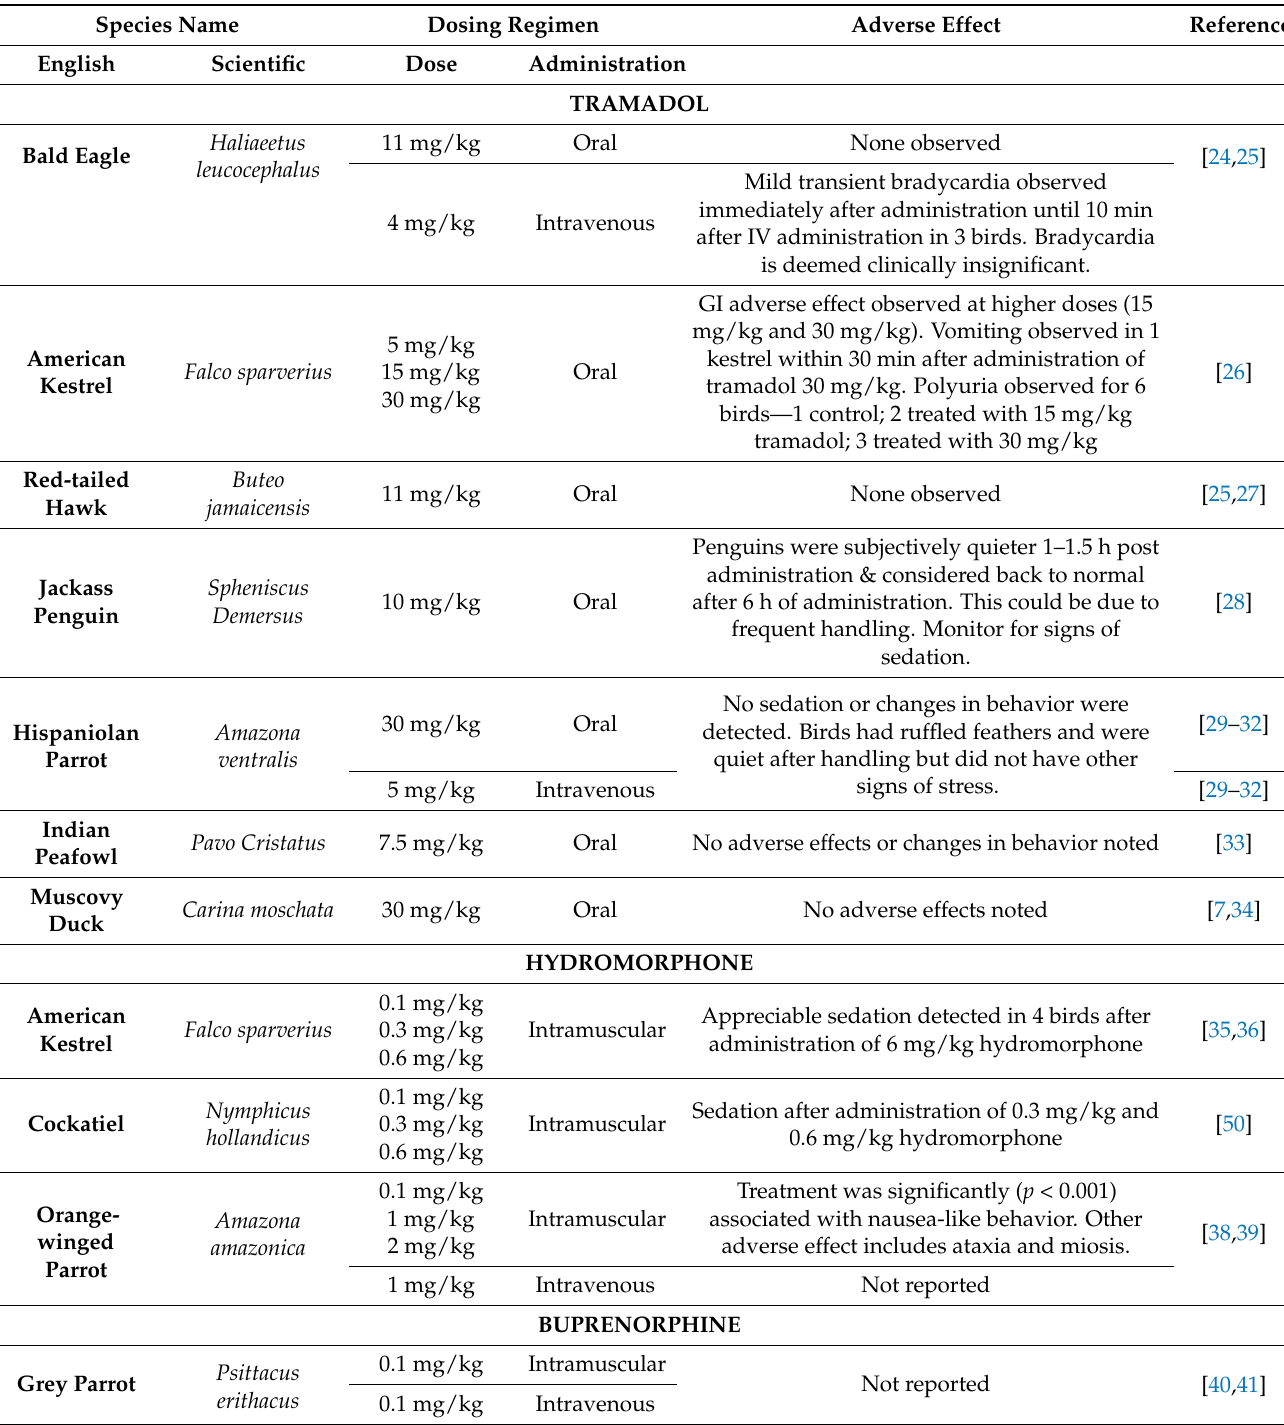
Table 4. Adverse effects of selected opioids reported in species